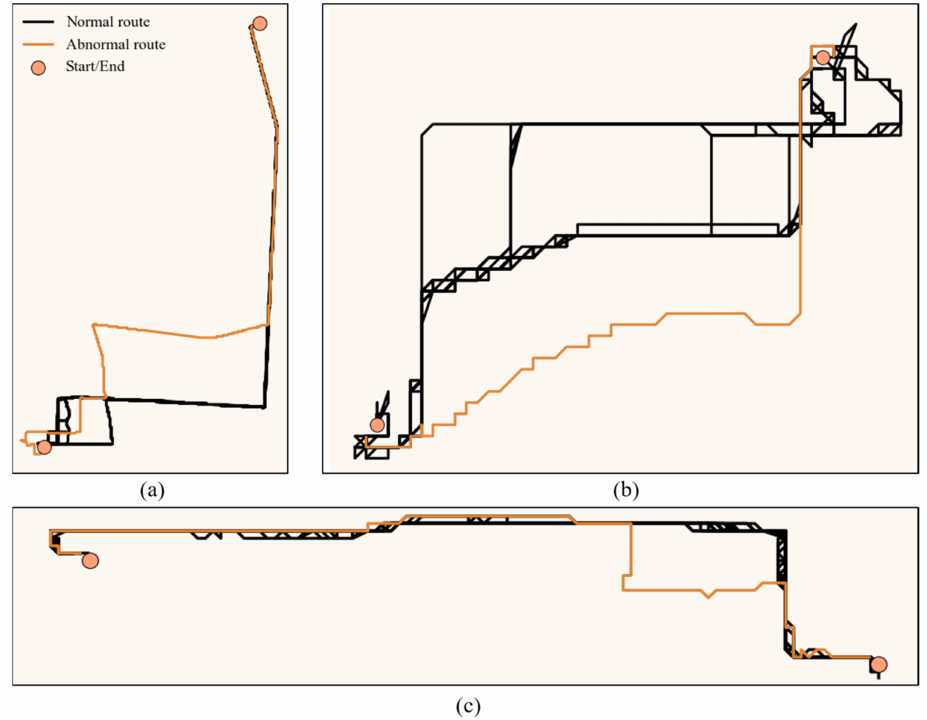
Figure 13. Examples of the unusual routes that were detected from the TucityLife dataset. ( a – c ) Several trajectories of unusual (brown) and normal (black) routes which are mapped on 50 m × 50 m